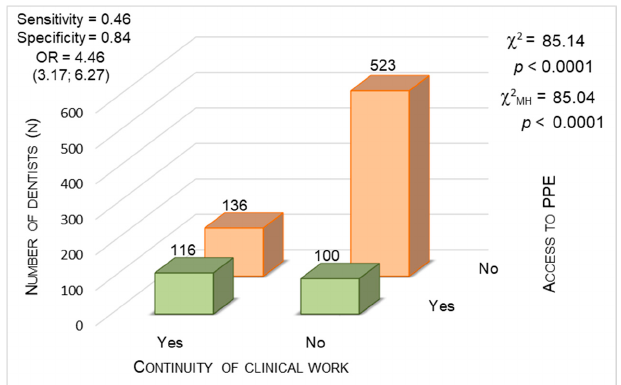
Figure 1. Continuity of clinical work during the COVID-19 outbreak in Poland vs. access to personal protective equipment (PPE) ( p < 0.0001, chi-square test).